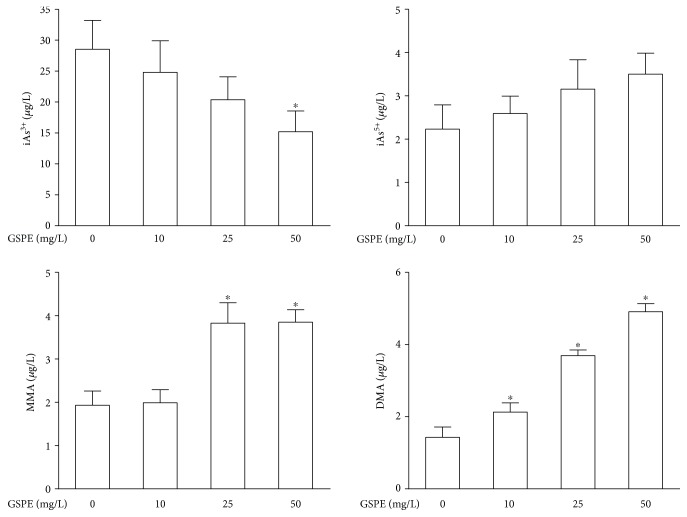
Effect of grape seed procyanidin extract on arsenic methylation (mean ± SD, n = 3). ∗Versus the arsenic only group, P < 0.05. Treatment with 50 mg/L GSPE caused a marked decrease in iAs3+ levels compared with the arsenic group. However, MMA content was significantly higher in the 25 and 50 mg/L GSPE groups than in the arsenic group. DMA content in each GSPE group was higher than that in the arsenic group.